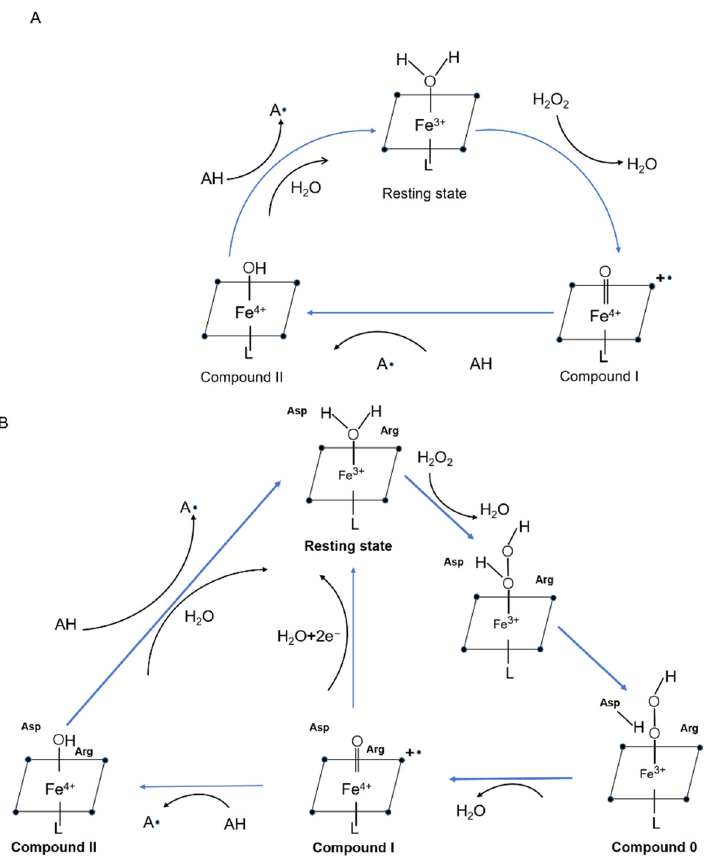
Figure 2. The typical catalytic cycle of heme peroxidases. The square represents the heme plane in the enzyme. AH stands for the substrate. ( A ) Conventional peroxidase catalyzed reaction mecha- nism. ( B ) catalytic mechanism of different DyPs. The activity of DyP-type peroxidase depends on the amino acid residues in the center of the enzyme that has the ability to catalyze aspartic acid and